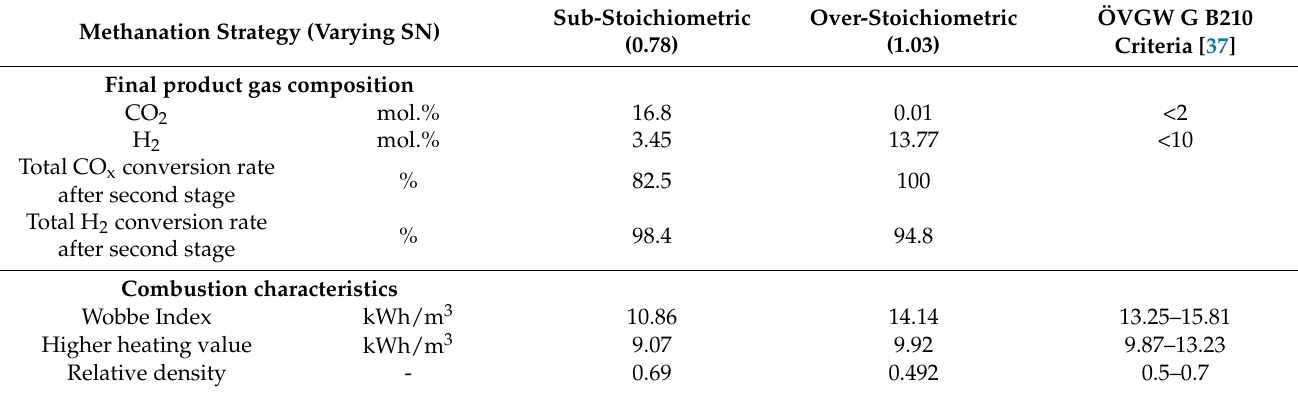
Table 5. Results of double-stage methanation experiments of steam gasification syngas in a laboratory plant at the Chair of Process Technology and Environmental Protection in